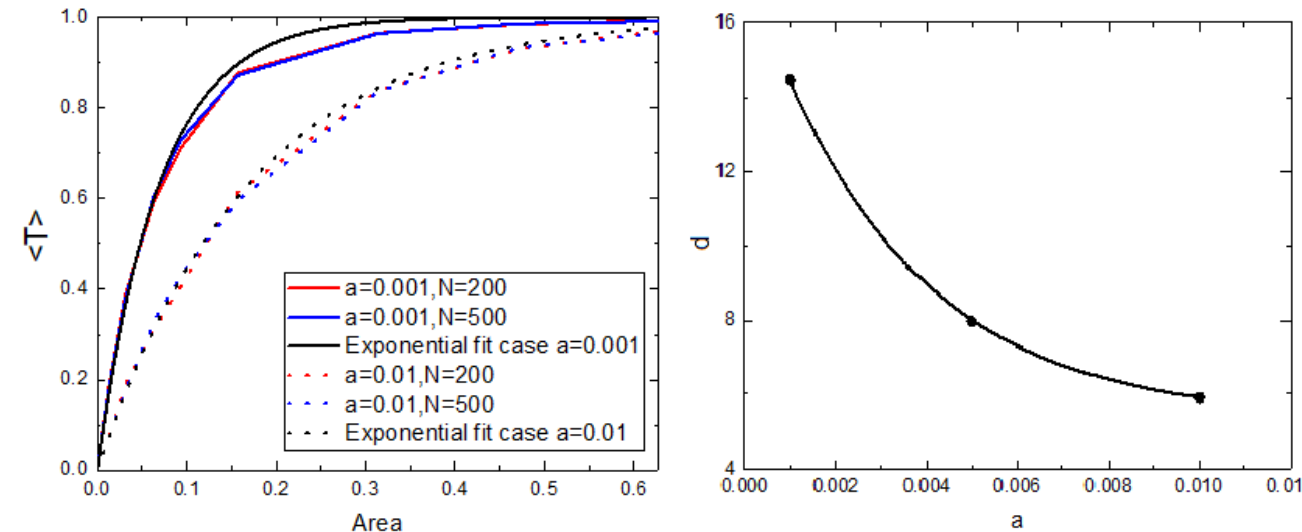
Figure 5. ( Left ) Average number of transmitted packages per unit of time as a function of the covered area for the case of random distribution of receiver stations. We include the cases a = 0.001 and a = 0.01 for N = 200 and N = 500. ( Right ) Exponent value d (obtained from exponential fits to the numerical simulations) as a function of a . In both graphs we show results averaged over 100 realizations, 20,000 time steps were considered, v = 0.001 and r =